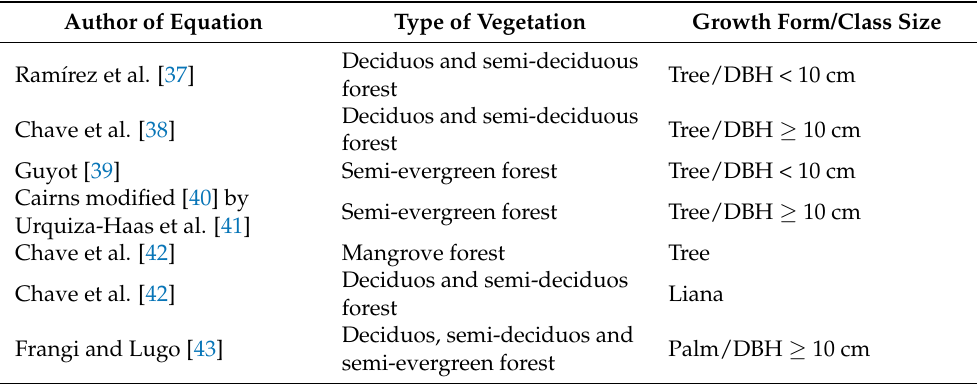
Table 1. Allometric equations used to estimate aboveground biomass for the most important vegeta- tion types and plant growth forms in the Yucat á n